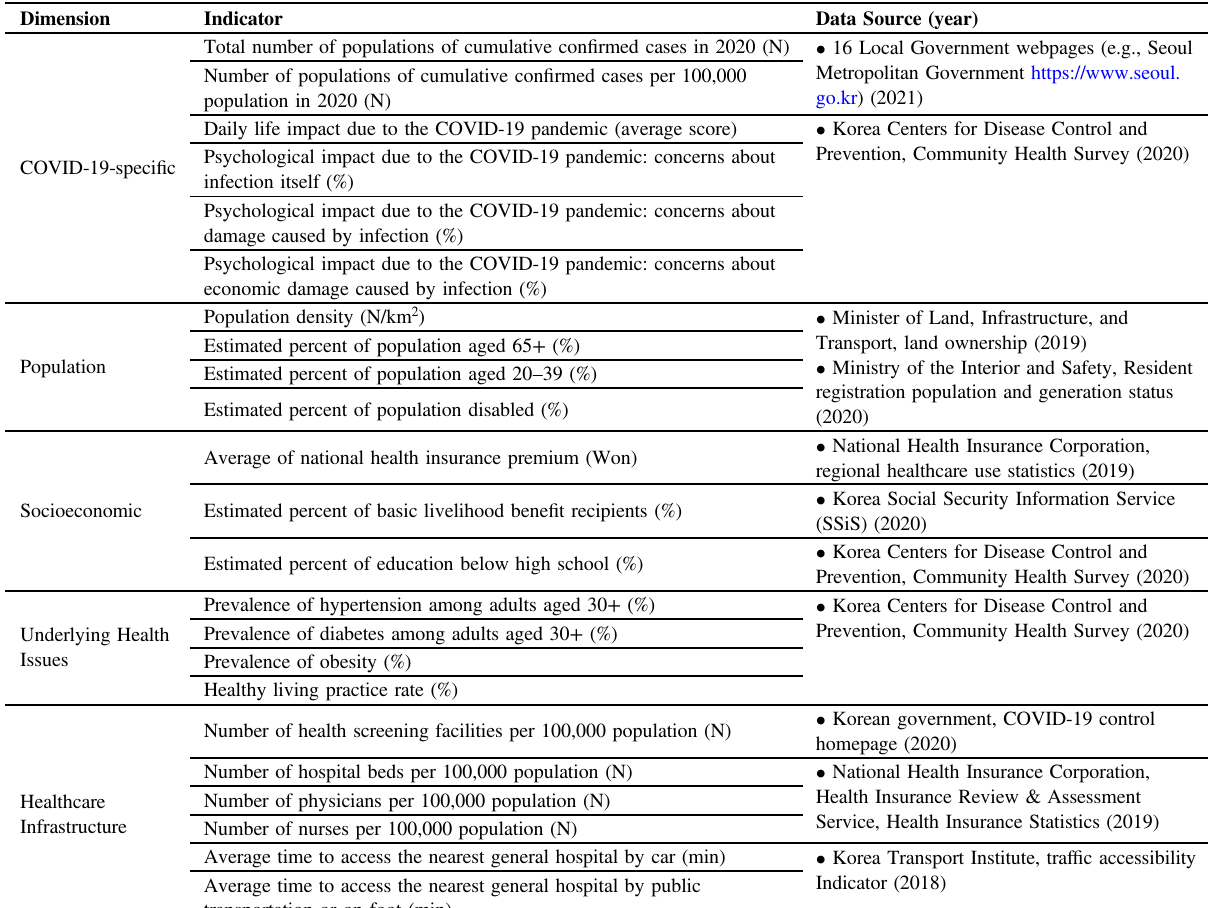
Table 1 List of explanatory variables